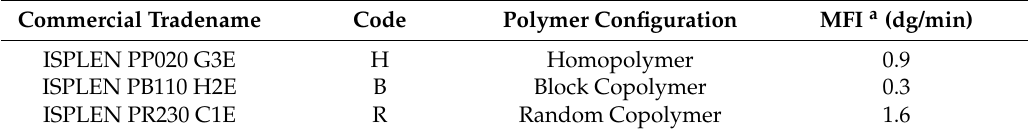
Table 1. Commercial polypropylene and polypropylene–ethylene resins selected.